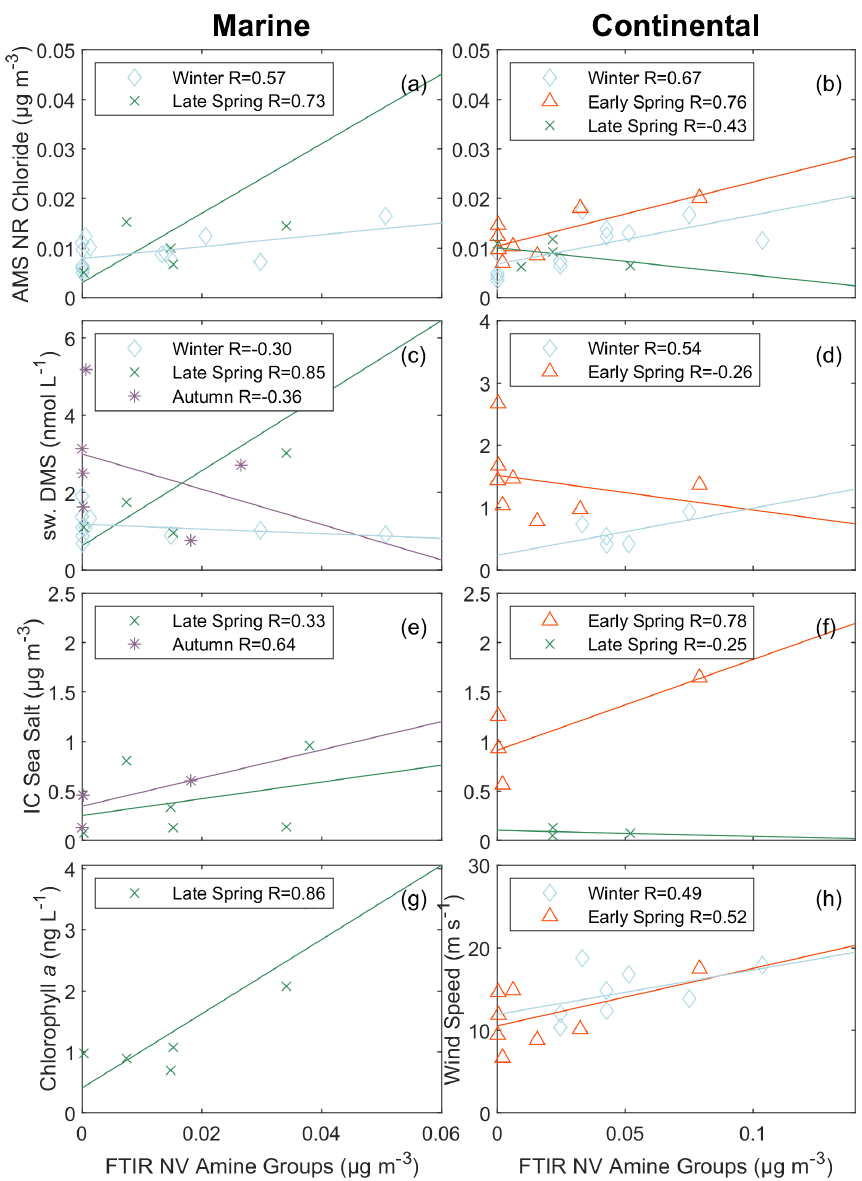
Figure 3. Scatterplot of marine tracers versus FTIR NV amine groups in particles with diameters < 1µm for marine periods (a, c, e, g) and continental periods (b, d, f, h) . The panels include AMS NR chloride (a, b) , seawater DMS (c, d) , IC sea salt (e, f) , chl a (g) , and wind speed (h) . Markers represent each cruise: blue open diamond – winter, green cross – late spring, purple asterisk – autumn, and red open triangle – early spring. The solid lines are the lines of best fit obtained using an ordinary least squares regression for | R | ≥ 0 . 25 with the exception of chl a which only displays a fit for R ≥ 0 .